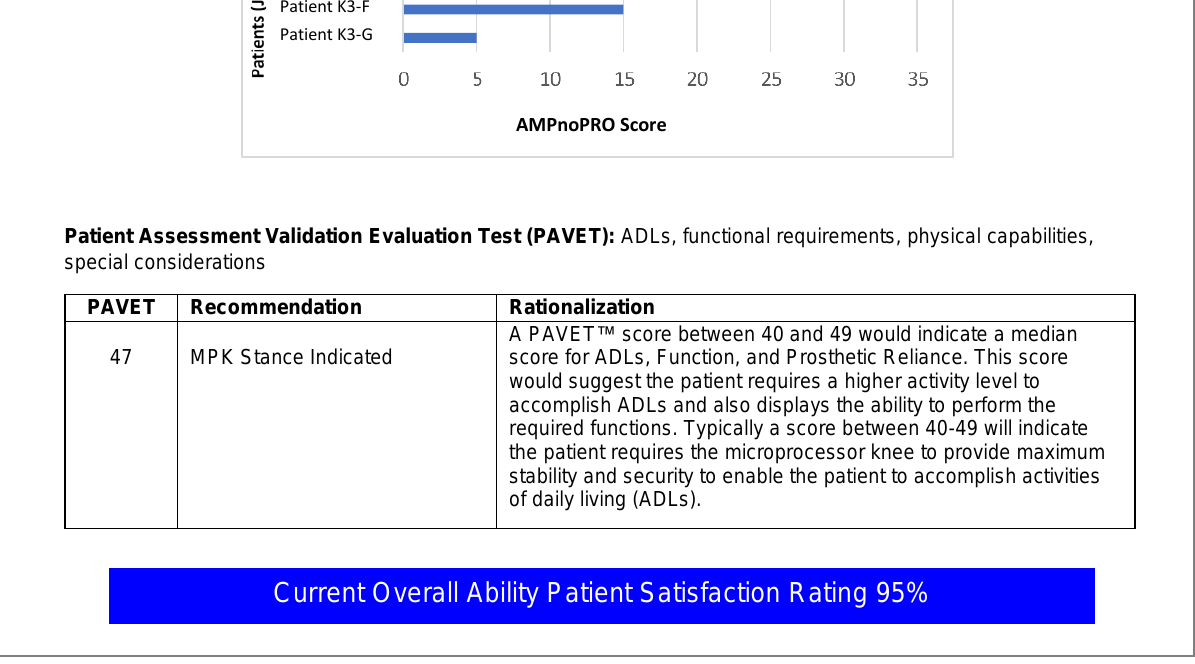
Figure 3: Example of Ability’s ‘Early Years’ individual patient outcome measure reports, with summary of delivery timeline and revisions/readmissions, AMPnoPRO results presented in graphic form with seven other K3 (randomized, anonymous) patients for comparison, PAVET score interpretation, and overall satisfaction survey rating, based on an in-house standardized, satisfaction